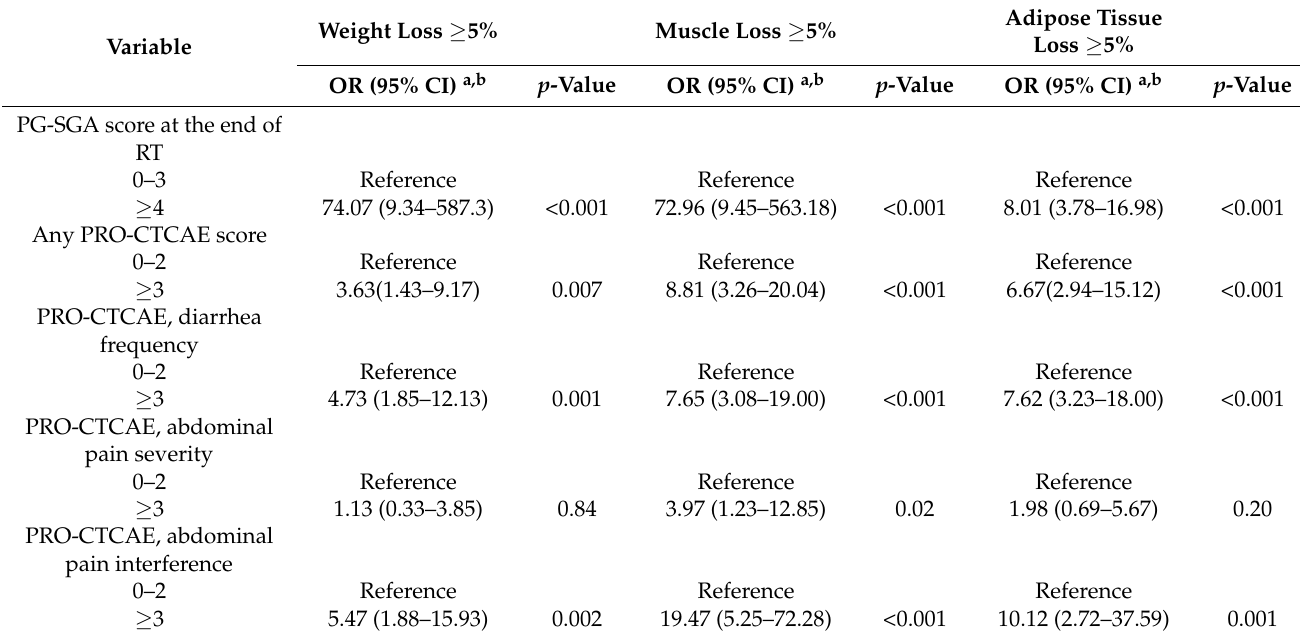
Table 4. Multivariable logistic regression analysis of factors associated with body composition changes.